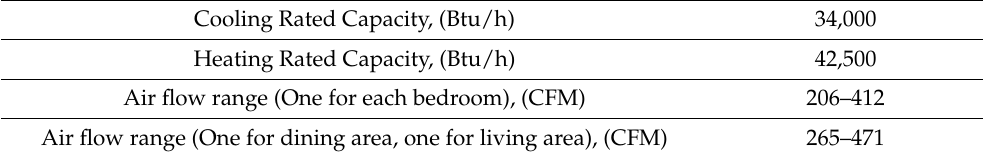
Table 2. HVAC characteristics.